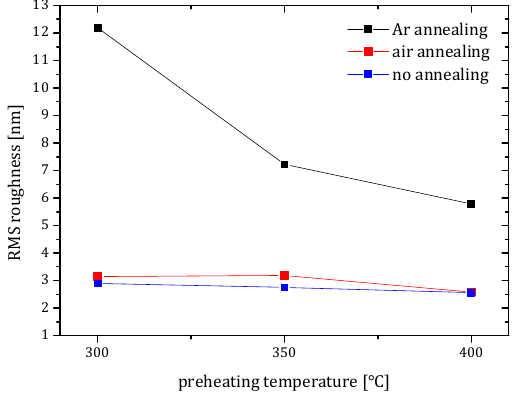
Figure 3. Dependence of the root-mean-square (RMS) roughness on the heat treatment conditions employed in the preparation of the seed layers. The heat treatment involves preheating at different temperatures and annealing either in the air at 600 °C (red) or in Ar at 800 °C (black) or without any annealing (blue).